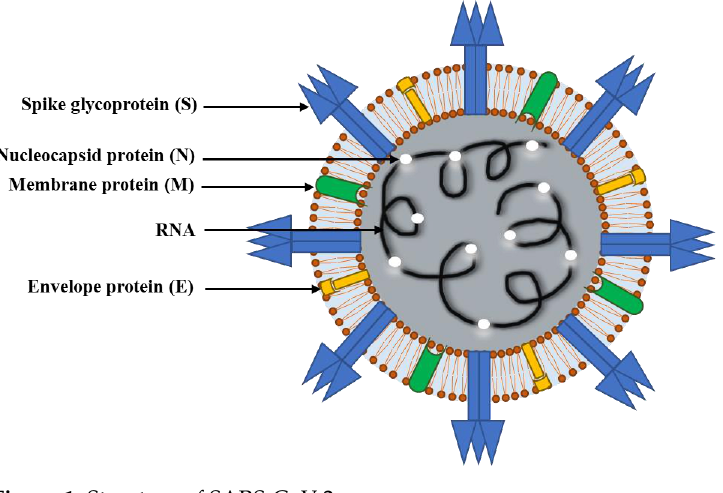
Figure 1. Structure of